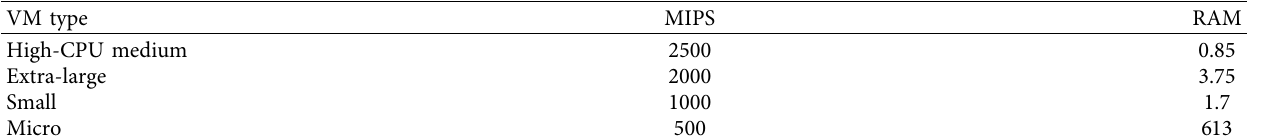
Table 5: Specifications of virtual machines.